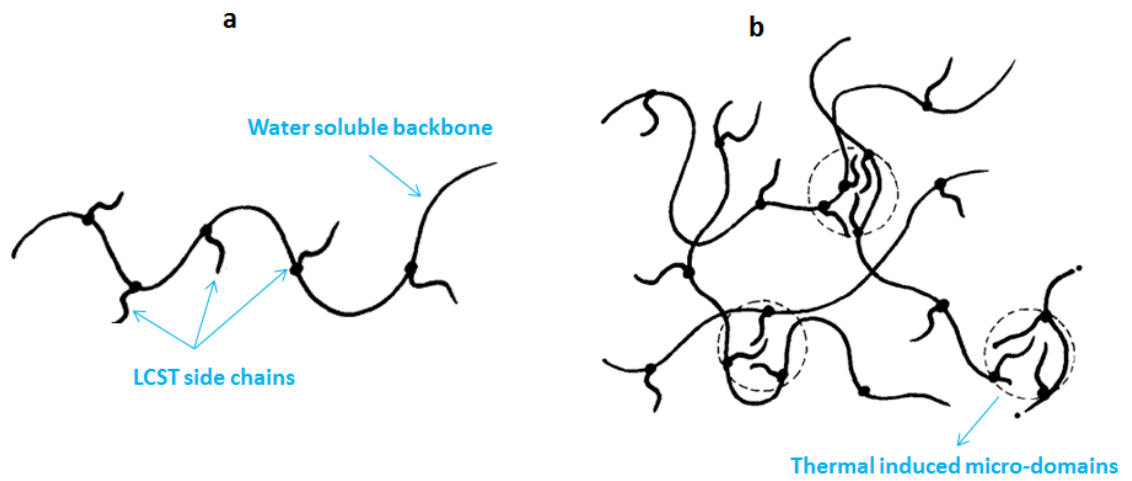
Figure 6. Thermo-associative concept in aqueous solutions: ( a ) copolymer structure; ( b ) association mechanism ( T > LCST). Adapted with permission from [227].